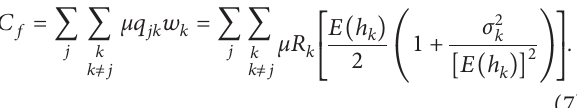
Figure 2: Initial bus routes